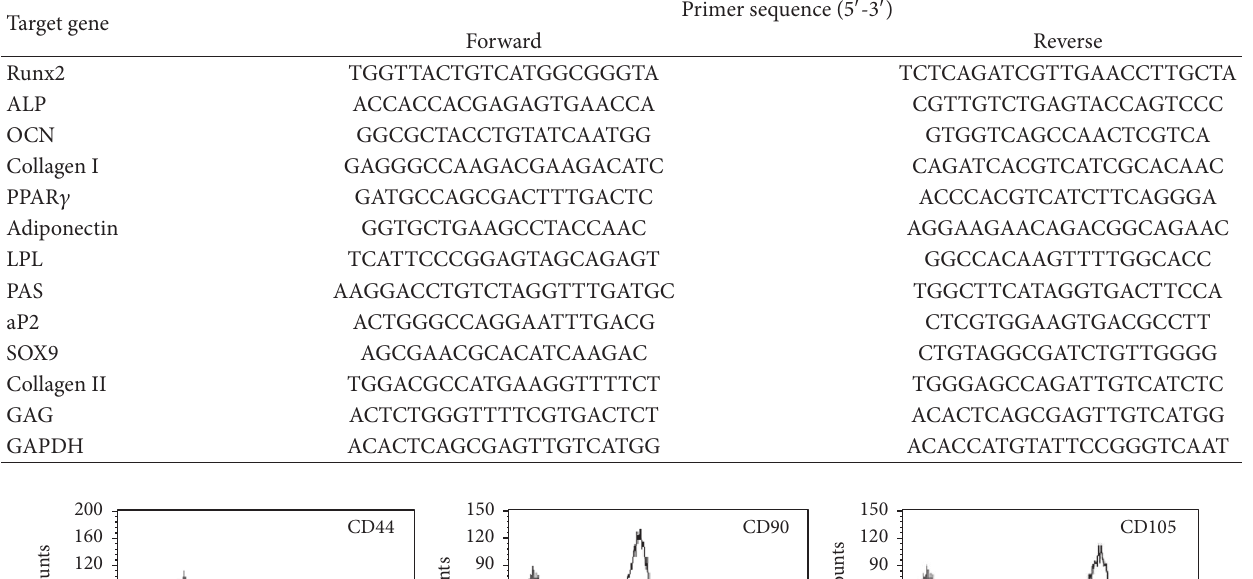
Table 1: Primer sequences for quantitative real-time PCR.